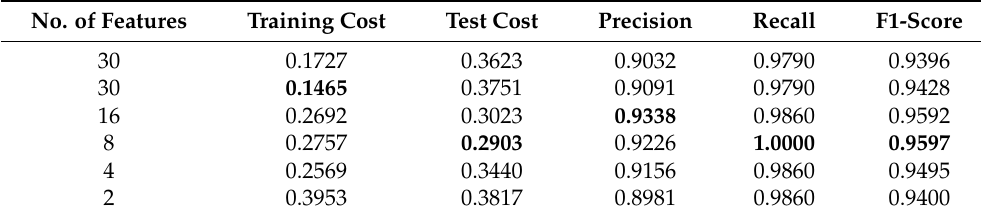
Table 2. Test set assessment outcomes for training performed on the UCI ML Breast Cancer Wisconsin (Diagnostic) Dataset training set. Corresponding training costs are also given. In each row, training was performed for 1500 iterations using the root mean squared propagation optimizer (step size of 0.01) and a batch size of 10. All values are given to four decimal places. The features in row 1 did not undergo PCA, while the features from the rest of the rows did. A random seed of ’123’ was used in each row, for both the train-test split and for all subsequent evaluations. The best value for each column is shown in bold.